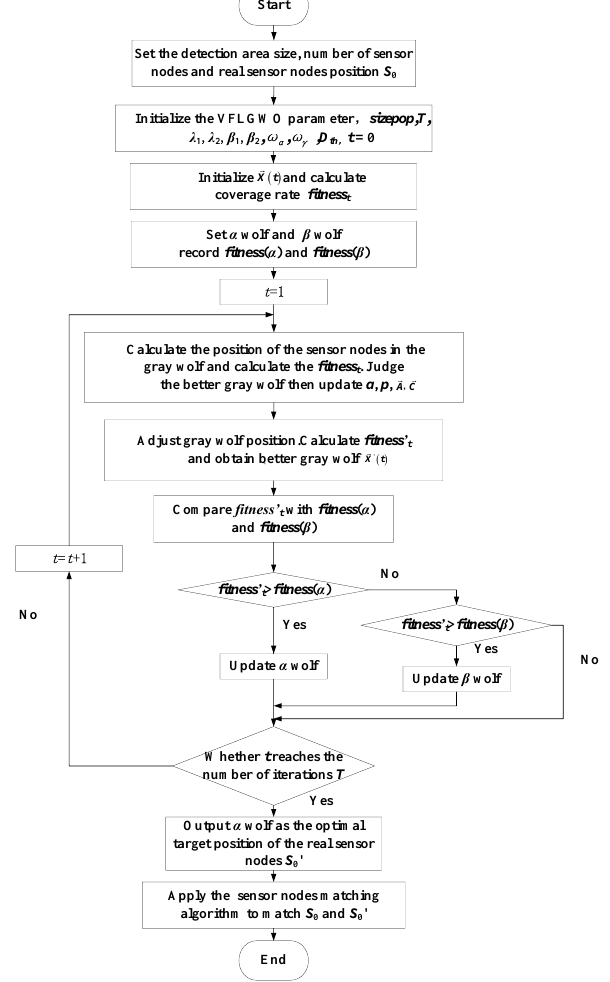
Figure 2. Process of the VFLGWO algorithm.